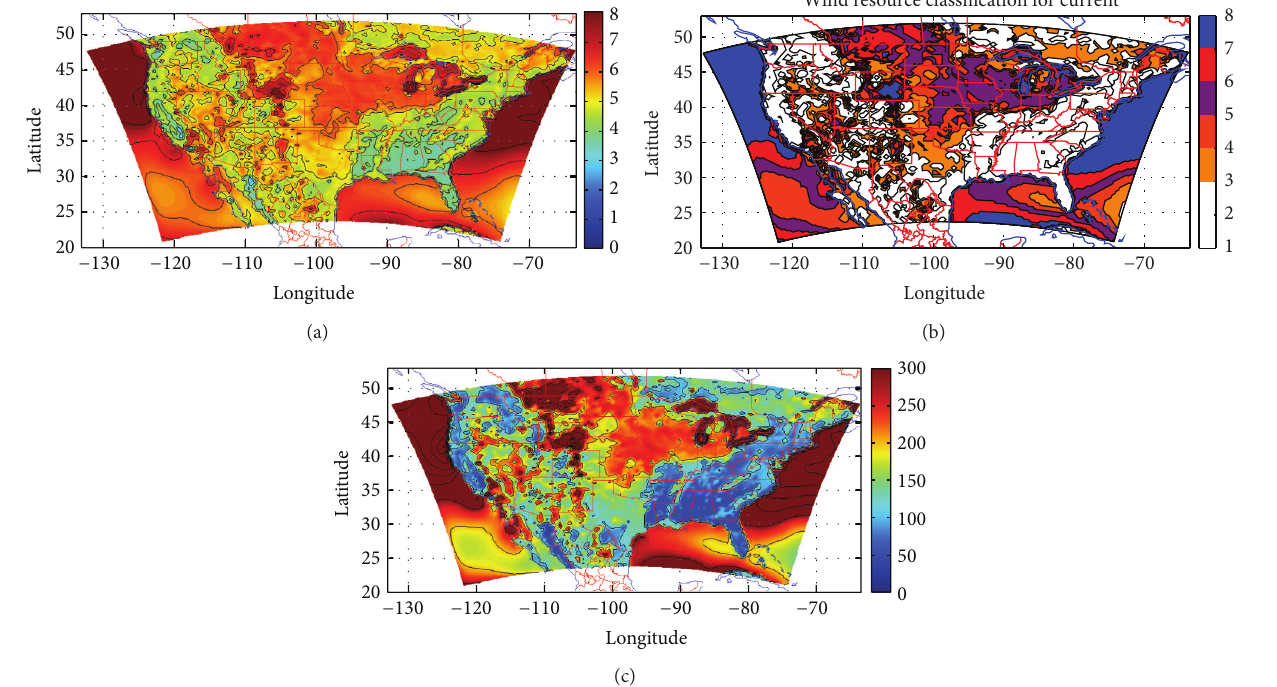
Figure 2: (a) Average annual wind speed (ms −1 ), (b) wind resource classification, and (c) average annual wind power density (Wm −2 ) for SSDA downscaled simulation in the CONUS region for current climate (1990–1999).